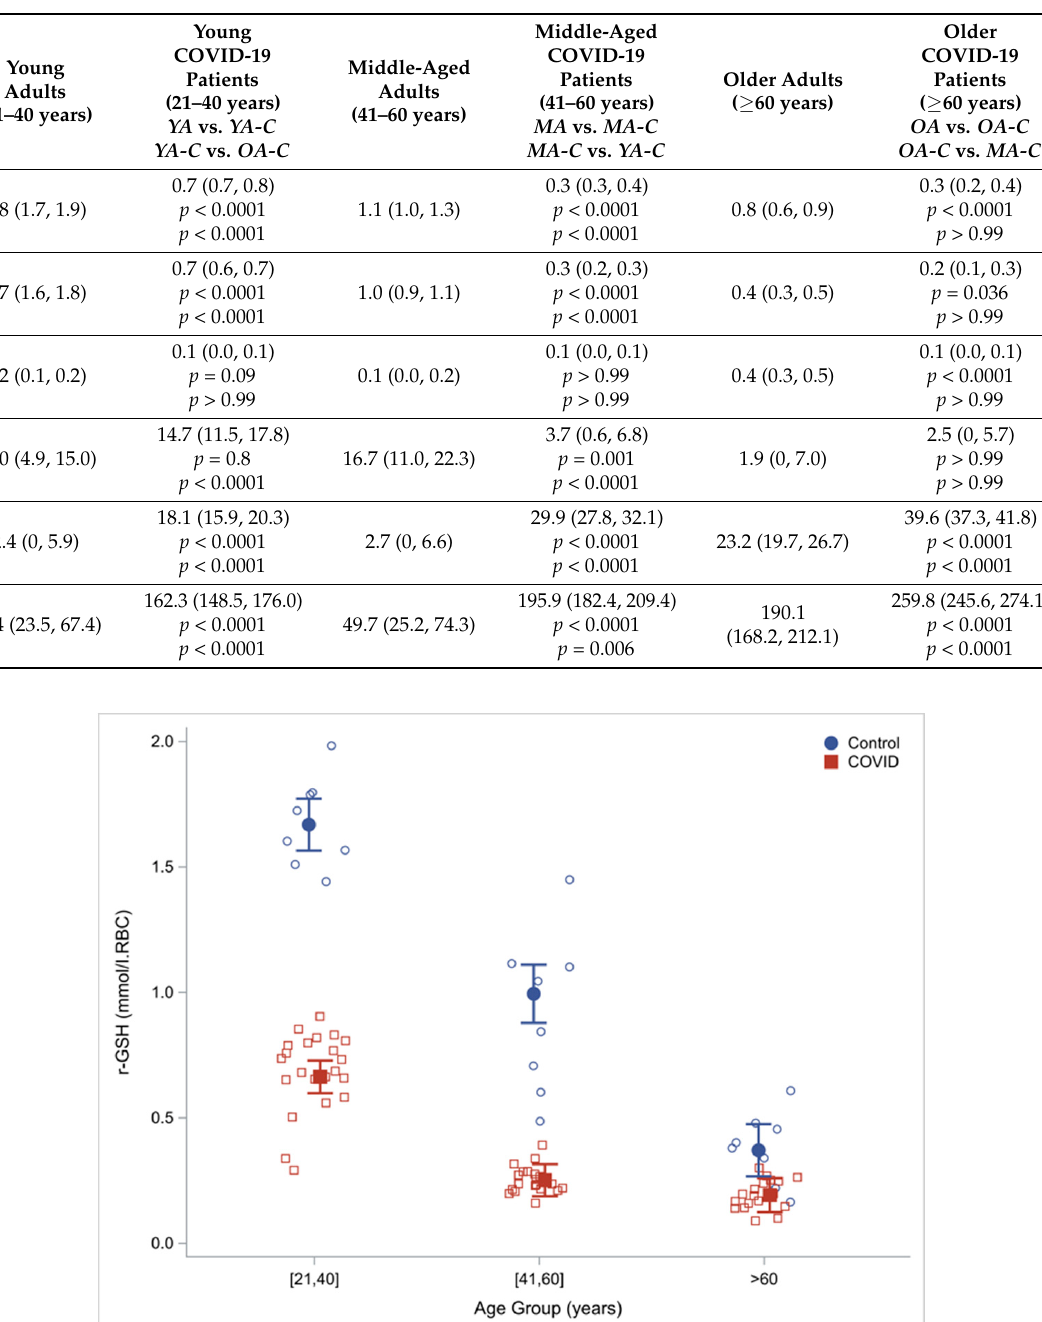
Table 3. Effect of age on intracellular glutathione and plasma biomarkers of oxidative stress and oxidant damage. Data are reported as multiple regression estimates (95% confidence intervals) adjusting for cohort, age group, and sex. p -values adjusted for multiple hypothesis tests using Bonferroni correction within each outcome measure. Means are significantly different at p < 0.05.